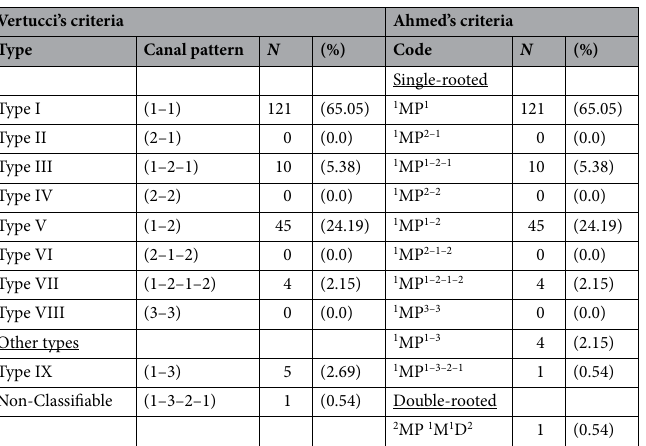
Table 2. Root canal system morphology of the analyzed mandibular first premolars according to Vertucci’s criteria and their correspondence with Ahmed’s criteria. D distal; M mesial; MP mandibular first